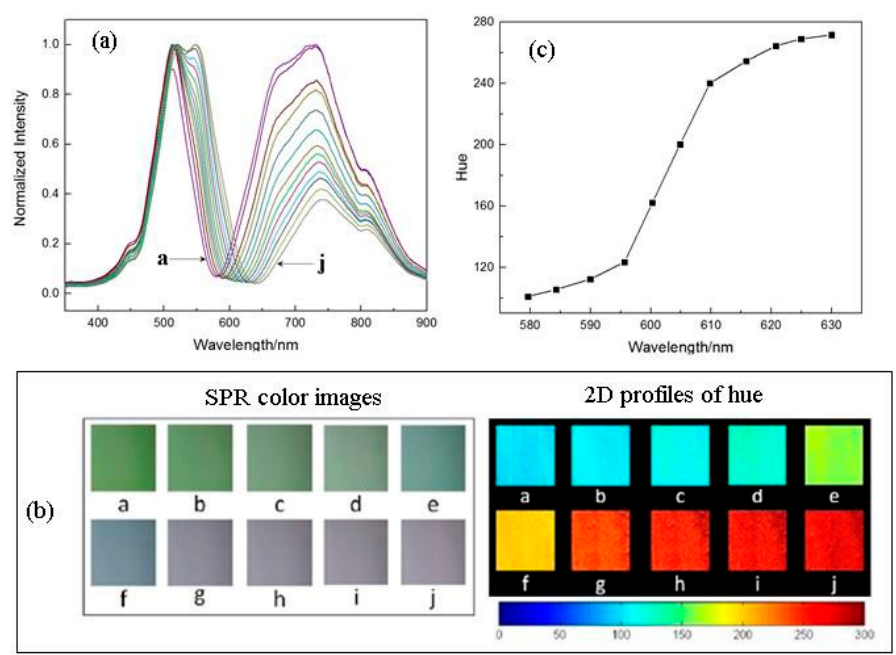
Figure 1. ( a ) ten SPR spectra and ( b ) ten SPR colour images and the corresponding 2D hue distributions (both spectra and images were measured at ten angles of incidence using the water- covered AuAg alloy film), ( c ) the average hue versus the resonance wavelength determined with the SPR